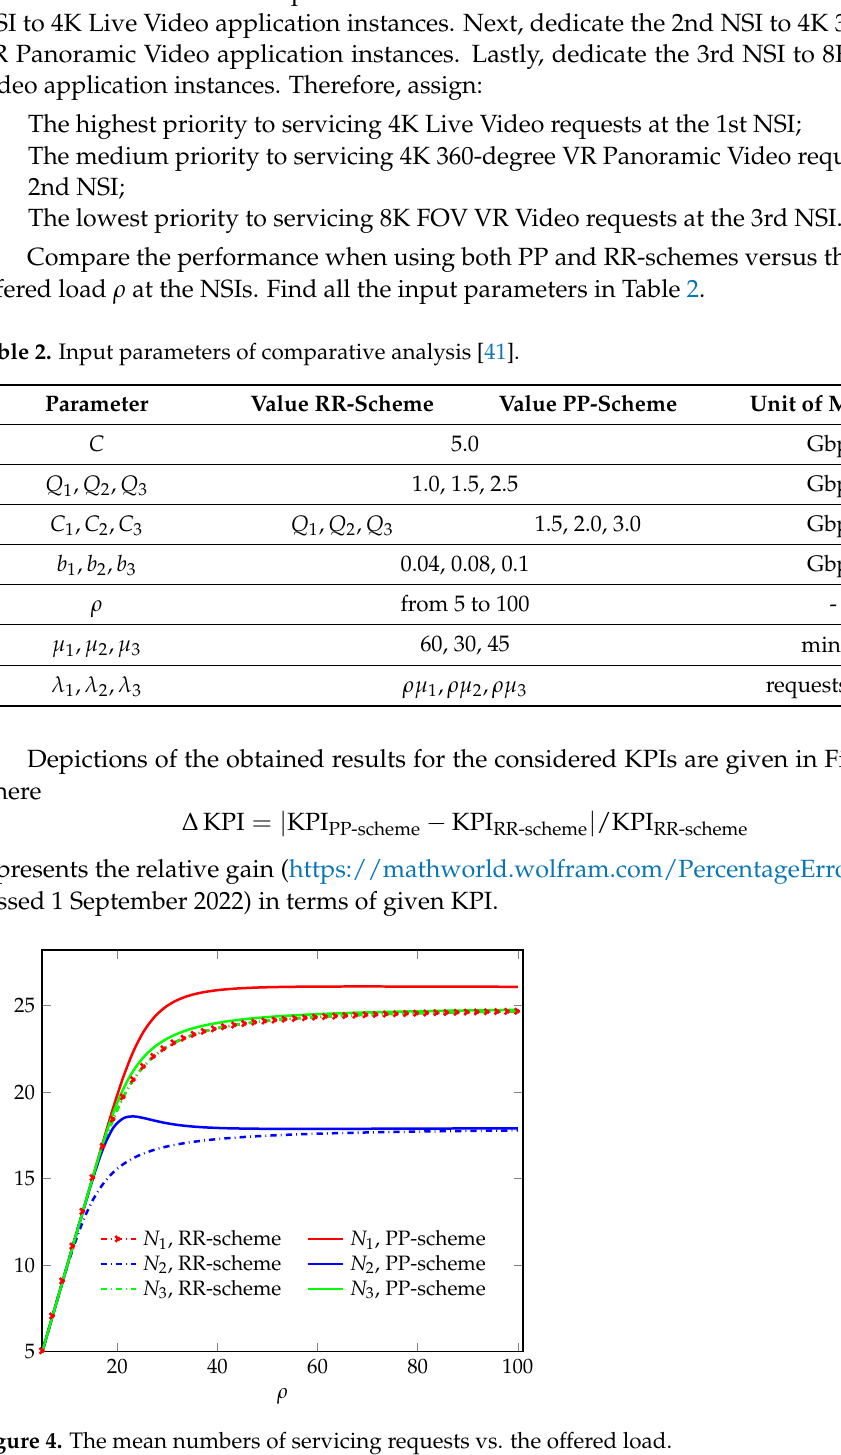
Figure 4. The mean numbers of servicing requests vs. the offered